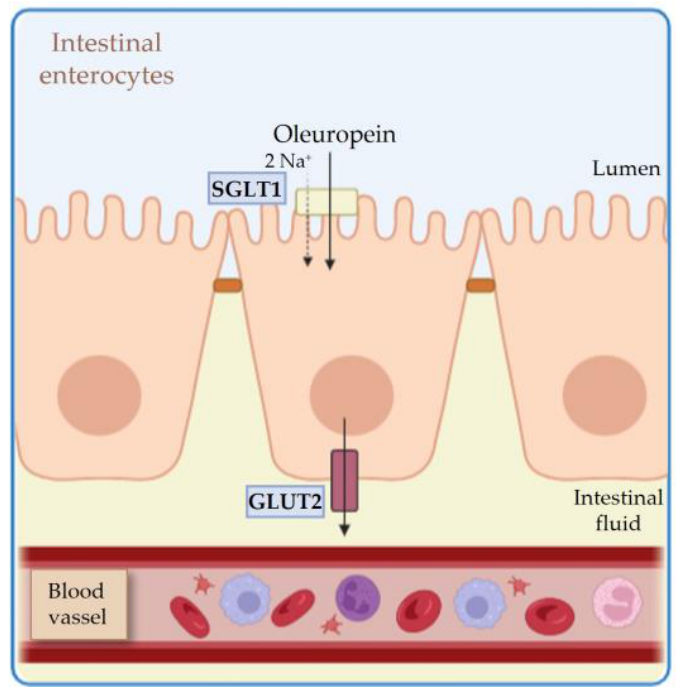
Figure 3. OLE alternative metabolism in small intestine. HTyr is the best absorbed phenolic compound in the intestinal tract with an effi- ciency ranging from 40% to 95% depending on the residence time, reaching the peak concentration in human plasma 1 h after ingestion [73]. HTyr uptake follows passive bi- directional diffusion across the human enterocyte membrane [72]; moreover, the food matrix influences its absorption: oily matrices allow the absorption of HTyr more easily than aqueous solutions or yogurt [74,75]. Phenolic bioavailability is known to be influ- enced by several factors such as age, hormonal status, or gender, as described in the lit- erature [34,76]. 3.2. Metabolism and Distribution Despite the absorption processes of OLE described above, the potential therapeutic efficacy of this molecule is interesting. Several preclinical studies have shown that OLE is a ligand of the peroxisome proliferator-activated receptor α (PPAR α ) that regulates cytochrome P450 and controls lipid homeostasis, the activation of which mediates the pleiotropic effects of various vital functions of the body, making OLE a cardioprotective and neuroprotective agent [77]. In particular, OLE can act both as a substrate of P450s and as their inducer or inhibitor [78]. These properties lead to the consideration that OLE, in combination with drugs that are substrates of P450s, may modify their pharma- cokinetic and therapeutic efficacy. Once absorbed, HTyr is distributed through capillaries mainly to the muscles, testi- cles, liver, kidneys, and brain, with renal uptake 10 times higher than other organs [39,79], reaching the maximum plasma concentration about 7 min after oral intake [80]. Recent research suggests that the highest plasma concentrations are reached be- tween 30 min and 1 h after oral administration, being no longer detectable after 4 h [81]. Once absorbed, HTyr binds to plasma high-density lipoprotein (HDL), carrying out its antioxidant and cardioprotective capacity [82]. Its metabolism is rapid and has a plasma half-life of about 1 – 2 min; despite this, it shows excellent distribution capabilities in var- ious tissues, accumulating mainly in the kidneys and liver [83,84]. Its widespread distri- bution makes HTyr responsible for the many beneficial properties that distinguish it. Some authors demonstrated that after oral administration on rats of increasing doses of HTyr (1, 10, and 100 mg/kg), the main accumulation was in the liver, kidneys, and brain as well as in urine and plasma [85]. Enzymes involved in Phase II metabolism include sulfotransferase (SULF), acetyl- transferase (ACT), uridine 5 ′ -diphosphoglucuronosyl transferase (UGT), catechol-O- methyltransferase (COMT), which catalyze reactions giving rise to the corresponding